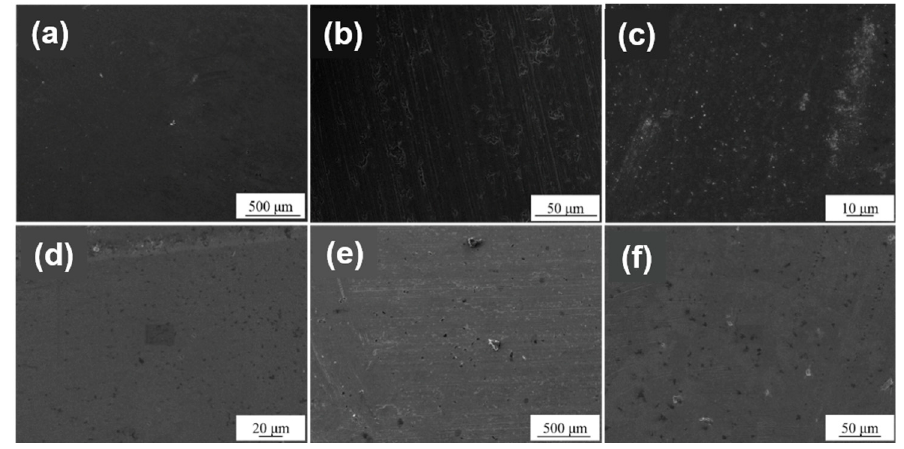
Figure 6. The SEM images of the alkaline-treated samples: TiN-1 ( a ), TiN-2 ( b ), TiN-3 ( c ), ZrN-1 ( d ), ZrN-2 ( e ), ZrN-3 ( f ).